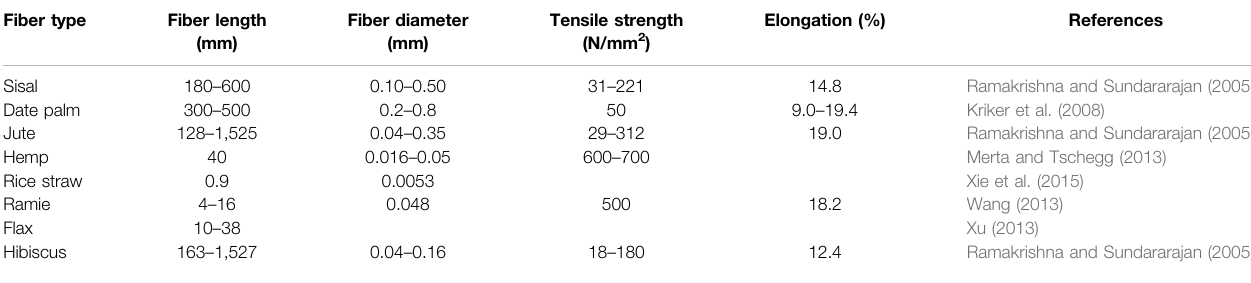
TABLE 1 | Physical properties of natural fi